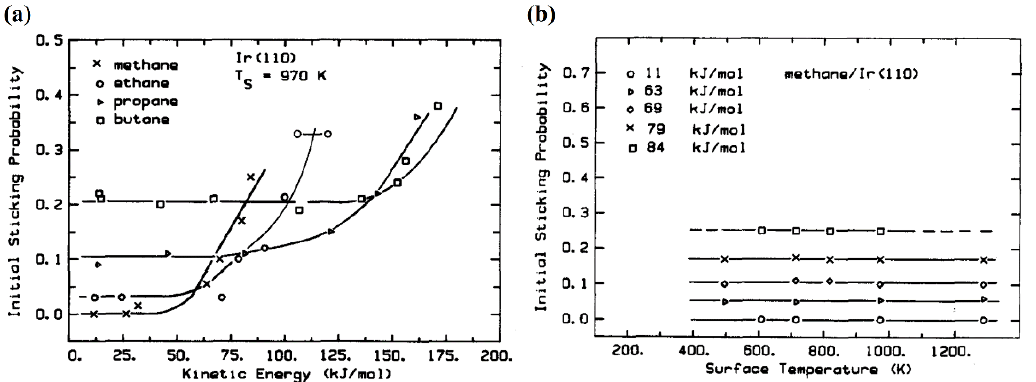
Figure 8. ( a ) Initial dissociative adsorption probability for C1-C4 alkane as a function of translational energy on the Ir(110) surface at 970 K [31]. ( b ) Initial dissociative sticking probability vs. surface temperature of methane on the Ir(110) surface [31].